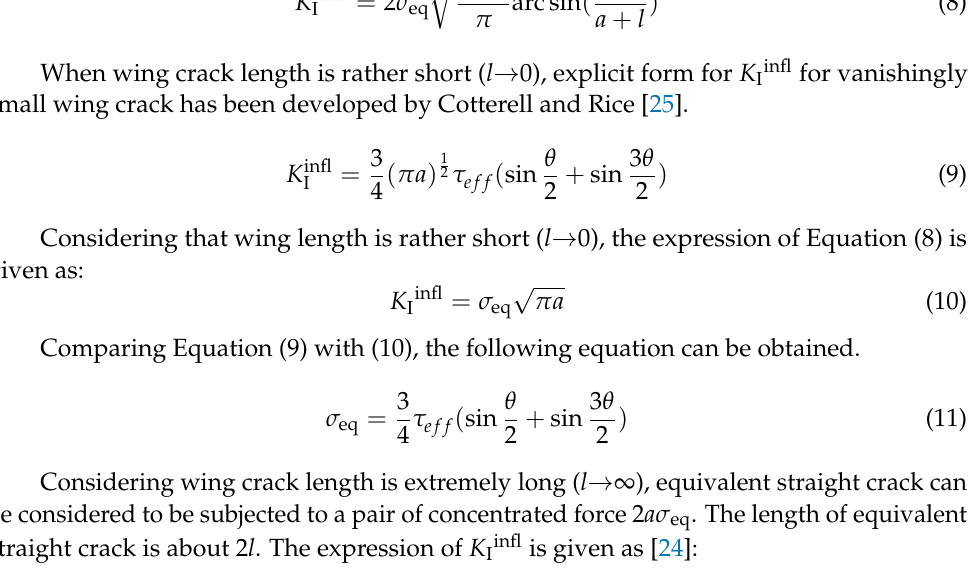
Figure 3. Simplification of the wing crack with τ eff acting on the main crack; ( a ) K Iinfl due to effective shear stress; ( b ) corresponding simplified diagram.